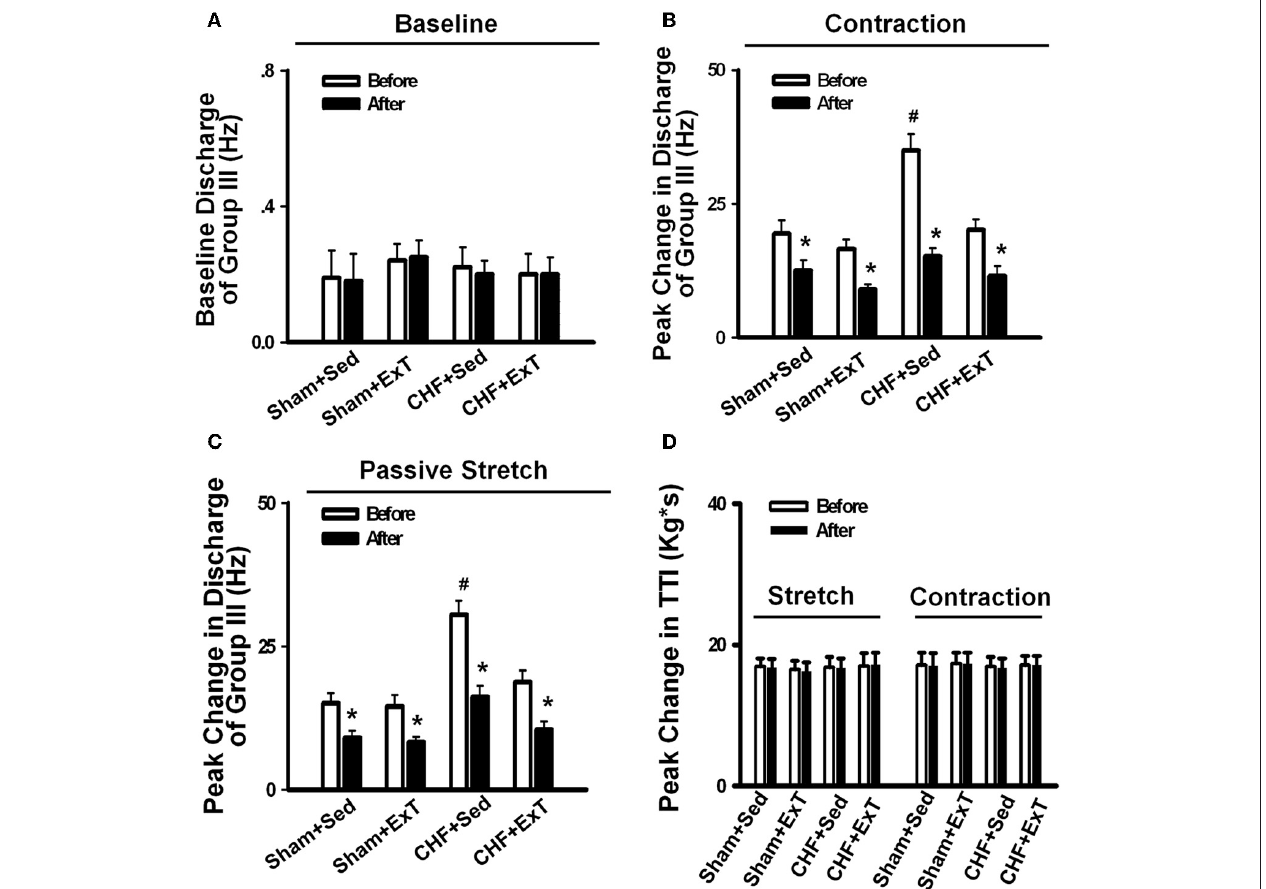
FIGURE 8 | Mean data showing the effect of PPADS, a P2X antagonist, on the baseline discharge (A) and the responses of group III afferents to either static contraction (B) or passive stretch (C) in Sham + Sed, Sham + ExT, CHF + Sed, and CHF + ExT rats. (D) The effect of PPADS on the TTI produced by passive stretch or